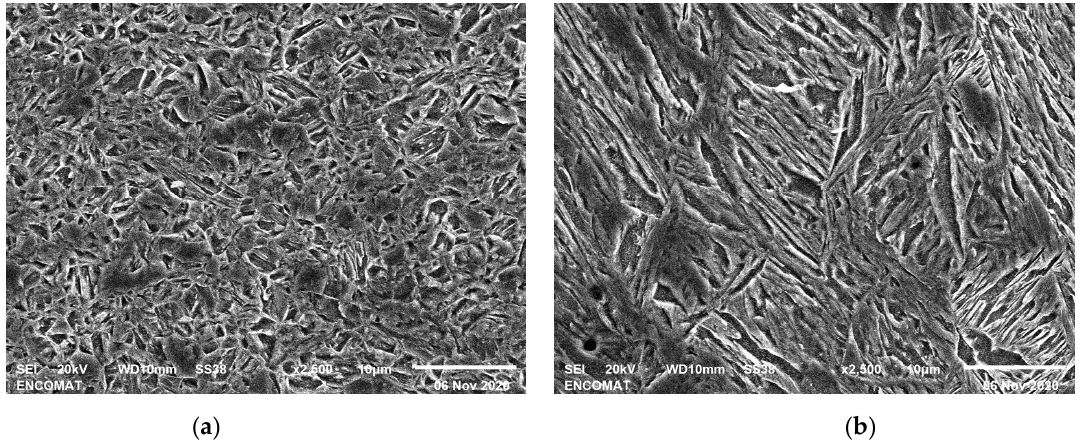
Figure 7. SEM of D min for f = 1000 Hz: ( a ) heat affected zone (HAZ); ( b ) fusion zone (FZ).